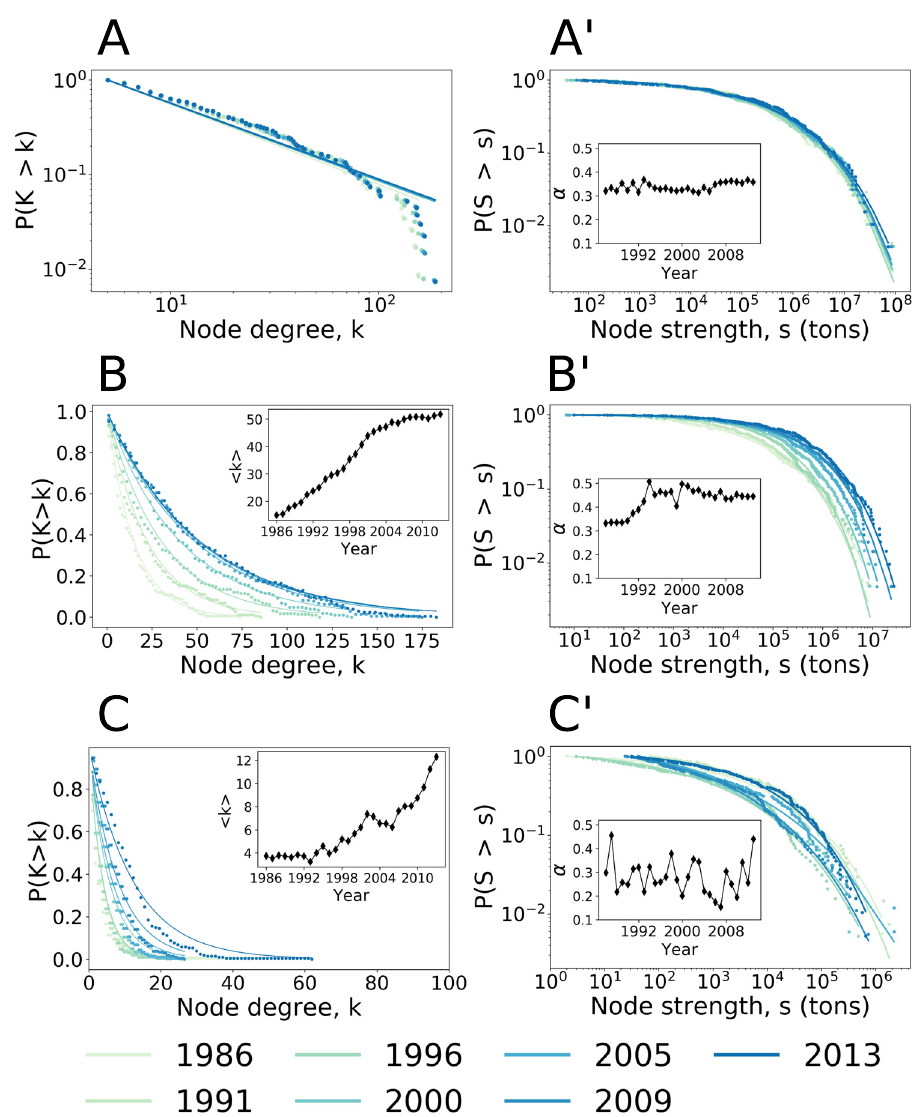
Fig 6. A, B, C: Degree distribution of the three subnetworks. A’, B’, C’: Node strength distribution of the three subnetworks . The distribution of the nodes strength follows a stretched exponential function of type P ( K > k ) = exp (( − λ k ) α ). The inset figures show the evolution of the average degree < k > (B and C) and the α parameter evolution of the stretched exponential equation (A’,B’,C’). A. Degree distribution of the backbone subnetwork . The degree distribution follows a power law of type P ( K > k ) / k − α ). The values for 2013 are k = 7 and α = 1.83 and the min Kolmogorov-Smirnov statistic is: D n = 0.077. As the α parameter is less than 2.0, the standard deviation and the mean ( < k > ) are undefined. The hubs are Belgium, USA, France, The Netherlands, Italy, Germany and United Kingdom. A’. Node strength distribution of the backbone subnetwork . The stretched exponential distribution and its α parameter are stable in time. B. Degree distribution of the intermediate subnetwork . The cumulative density (cid:0) � . In 2013, the average nodes degree is function fits with an exponential function of type P ð K > k Þ / exp (cid:0) k < k > < k > = 51.67 and the correlation coefficient is R 2 = 0.99. B’. Node strength distribution of the intermediate subnetwork . The stretched exponential distribution changes over time as shown by the decrease and stabilization of the α parameter. C. Degree distribution of the transient subnetwork . The degree distribution of the transient subnetwork fits with an exponential function. In 2013, the average node degree is < k > = 11.98. The correlation coefficient is R 2 = 0.97. C’. Node strength distribution of the transient subnetwork . The evolution in time of the stretched exponential distribution is erratic as shown by the random changes in the α parameter.